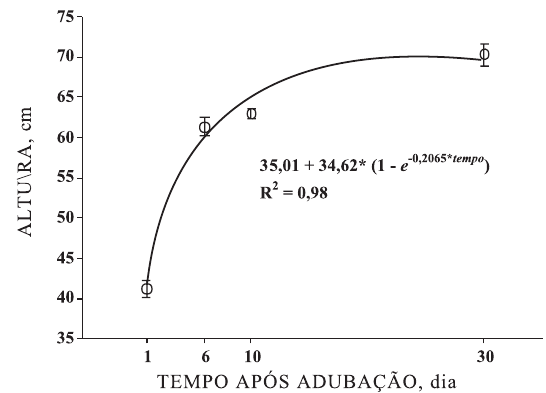
Figura 2. Altura da pastagem como variável dependente de doses de 15 N-ureia e do tempo após a adubação. Os coeficientes da equação apresentada são significativos (p < 0,0001). As barras verticais indicam o erro-padrão da média.